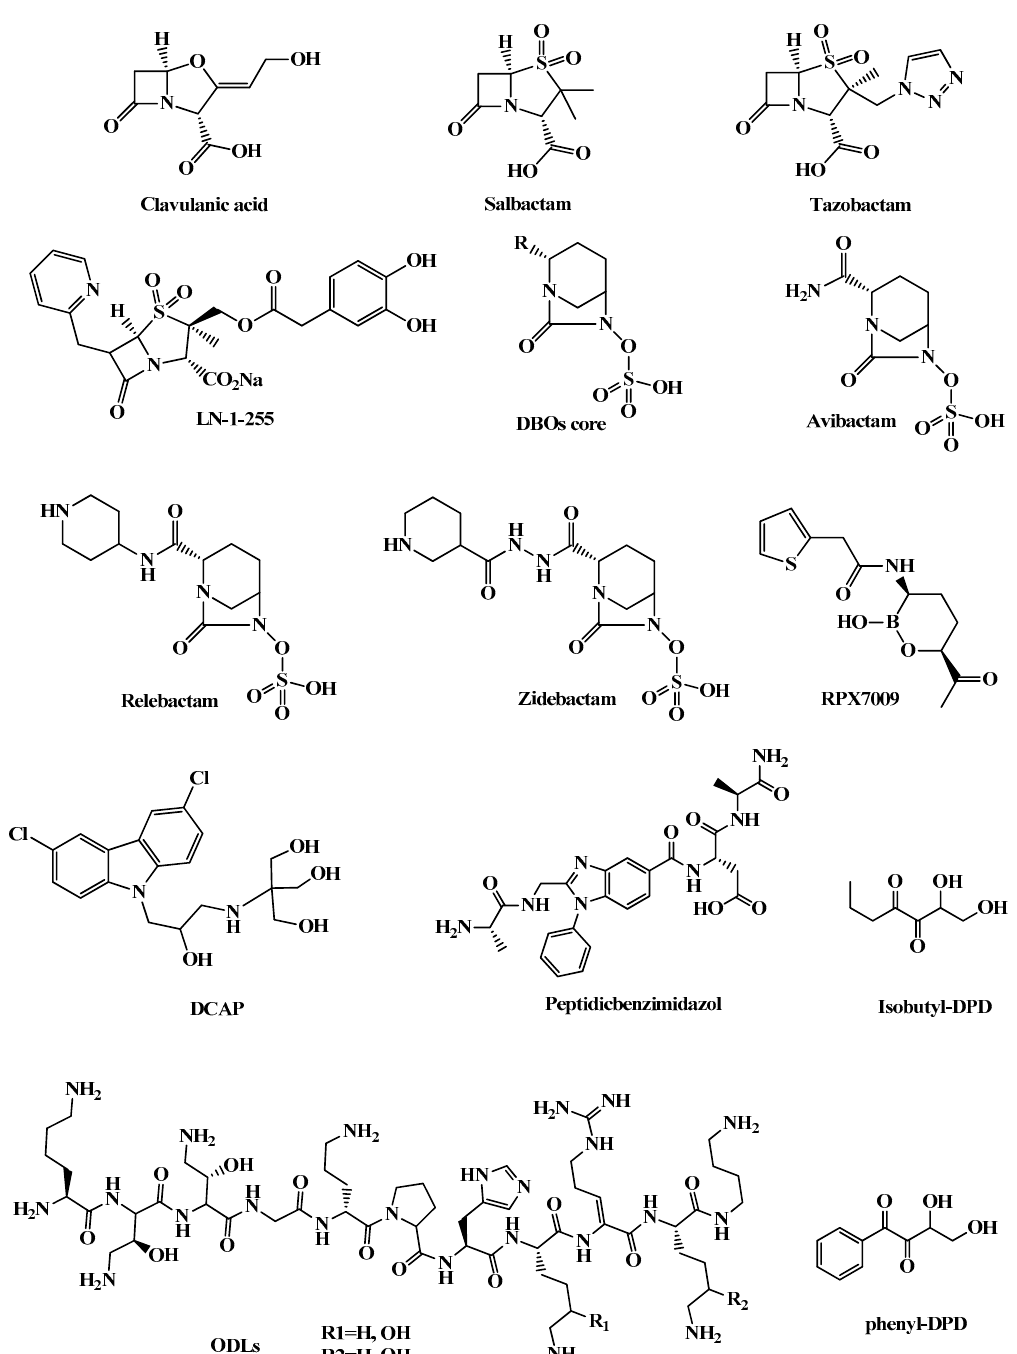
Figure 4. Chemical structures of clavulanic acid, salbactam, tazobactam, LN-1-255, DBOs core, relebactam, zidebactam, RPX7009, DCAP, peptidic benzimidazol, isobutyl-DPD and phenyl-DPD.